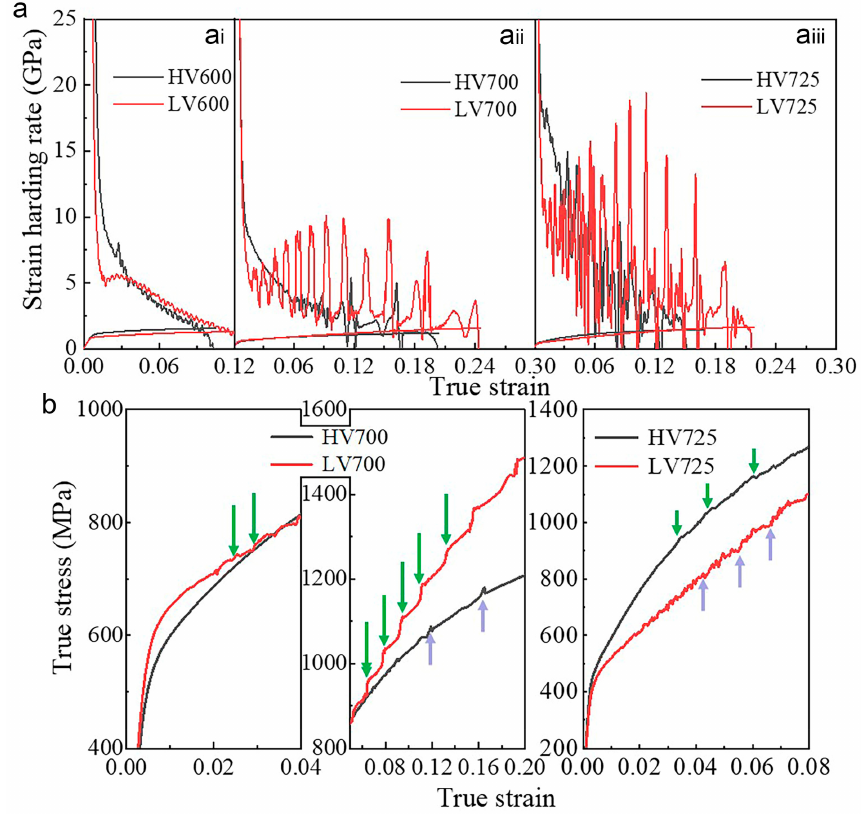
Figure 11. ( a ) True stress–strain curves and corresponding stain hardening rate curves of HV and LV steels annealed at ( a ) 600 ◦ C, ( a ii ) 700 ◦ C and ( a iii ) 725 ◦ C, respectively; ( b ) enlarged true stress-strain curves in ( a ii ) and ( a iii ), respectively. The green arrows refer to the serrations on the SHR curves for HV steels, while the purple ones refer to those for LV